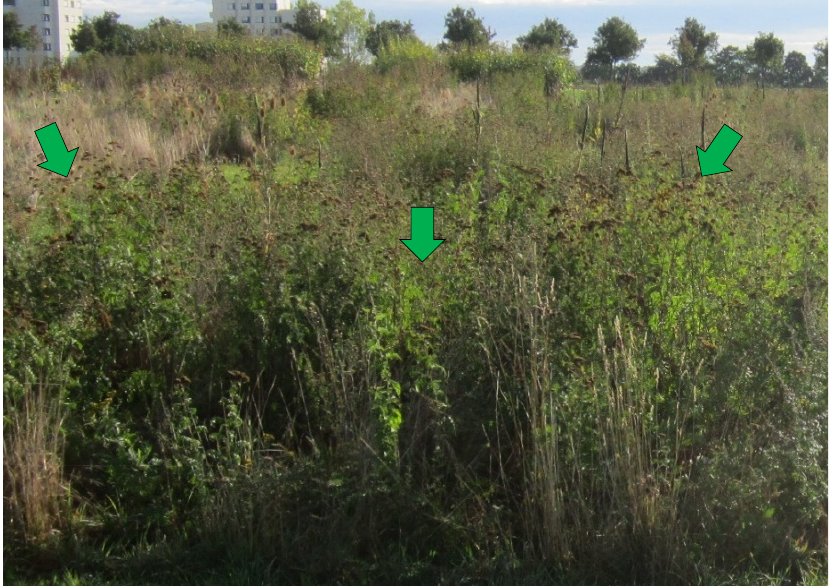
Figure 3. An overview of the WPM plant stand at harvest in 2015. The arrows indicate examples of individuals of common tansy, which dominated the plant stand.